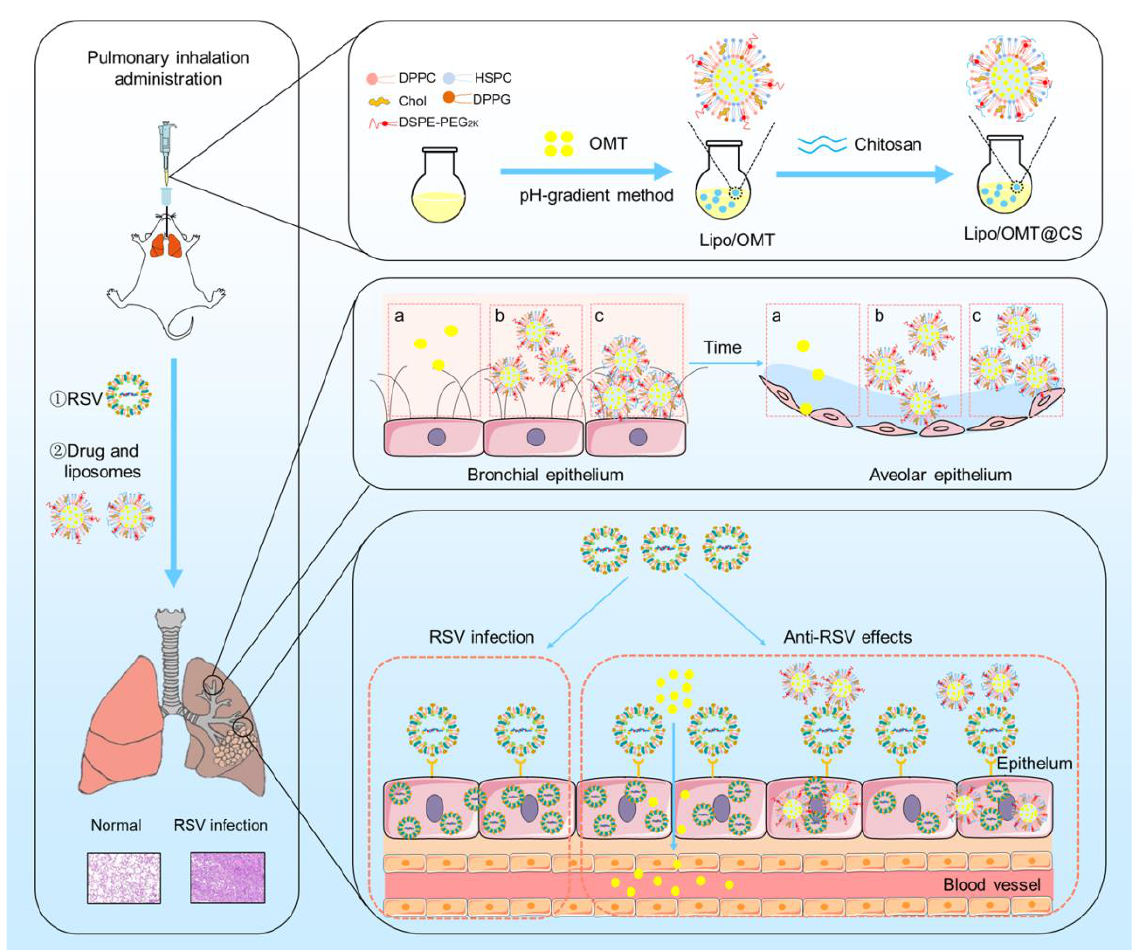
Figure 1. Schematic illustration of the preparation process of CS-coated OMT liposomes, the distribution after inhalation and the inhibitory effect on RSV infection (a: free OMT, b: Lipo/OMT, c: Lipo/OMT@CS).